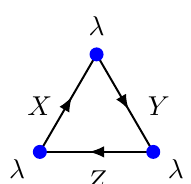
Figure 6 . The adjacency graph of the N = 4 theory seen as a (trivial) RSOS model. All vertices are identified. Here all fields are in the adjoint of the (single) gauge group and the model is not